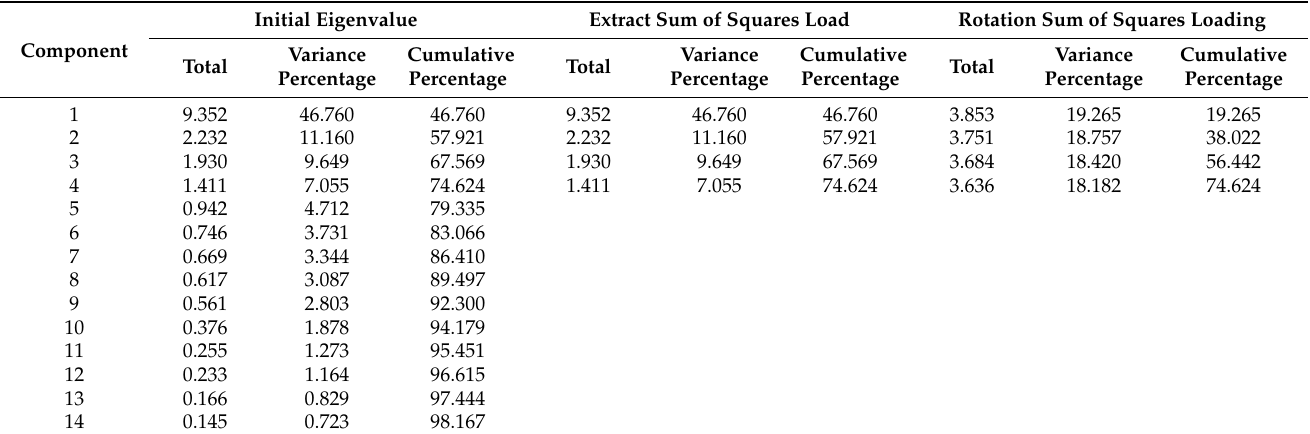
Table 2. Principal component analysis results.